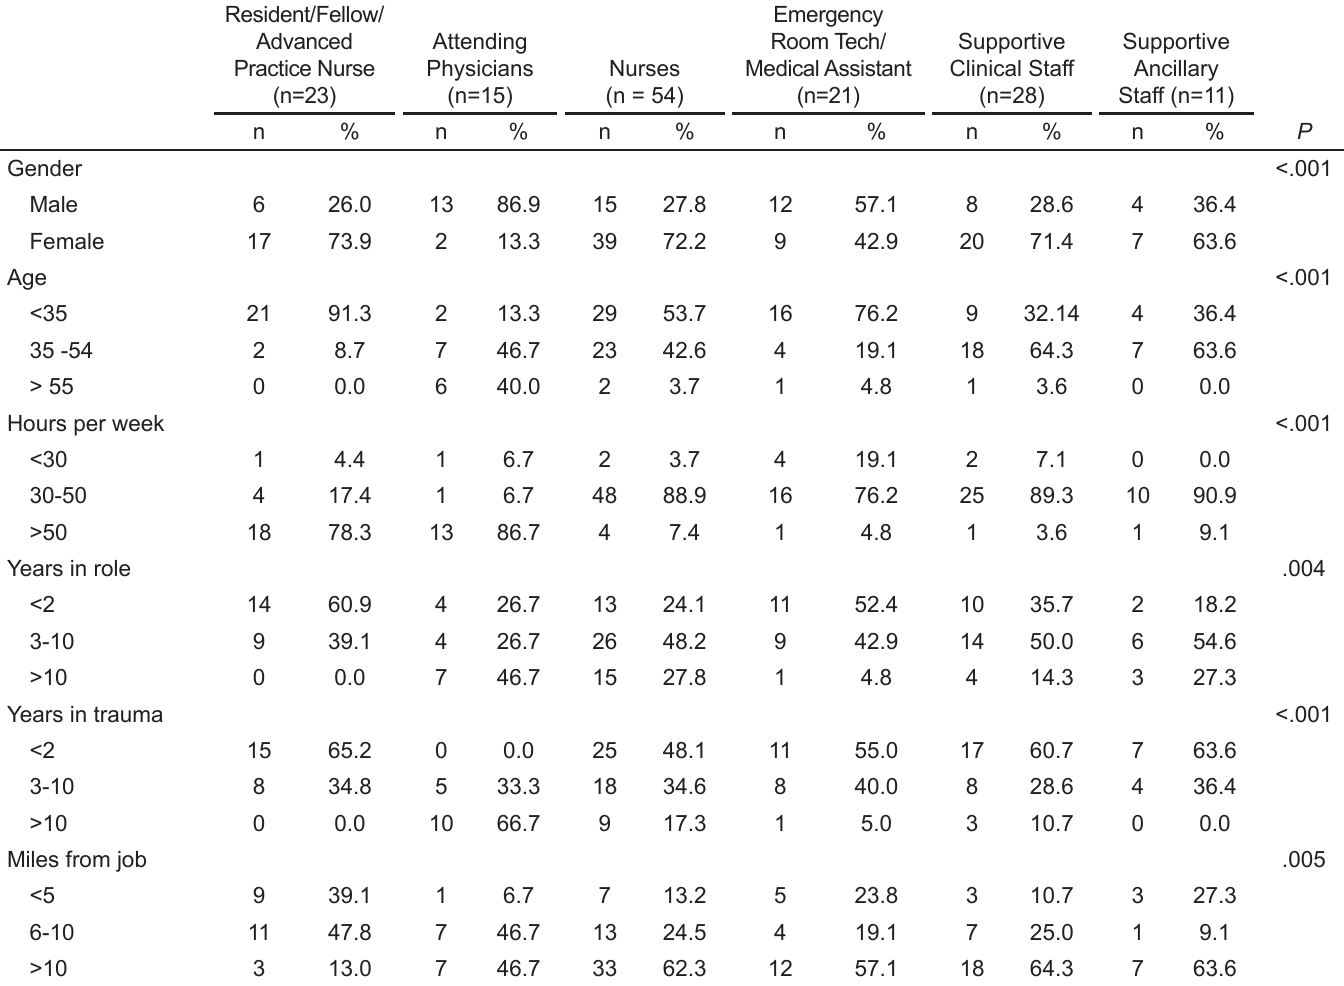
Table 1. Demographics and descriptive characteristics of emergency department